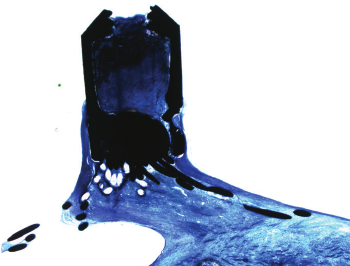
Figure 6: The PET-patch on the left atrial side (arrows) is completely covered by fibrous tissue and endothelium without major inflammatory reactions. Magnification 16 × , Richardson blue staining. PET: